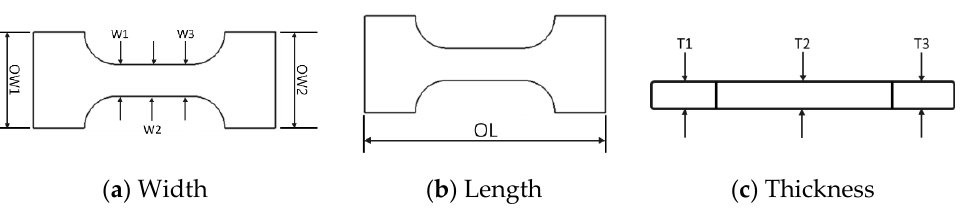
Figure 1. ASTM-D1708 specimen .